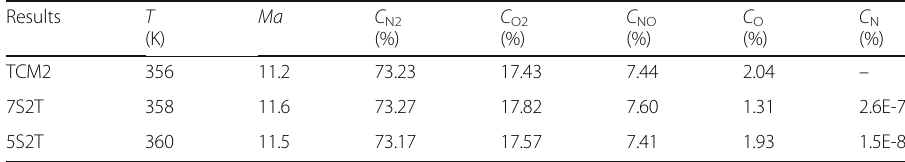
Table 5 Comparison of flow parameters in the TCM2 nozzle